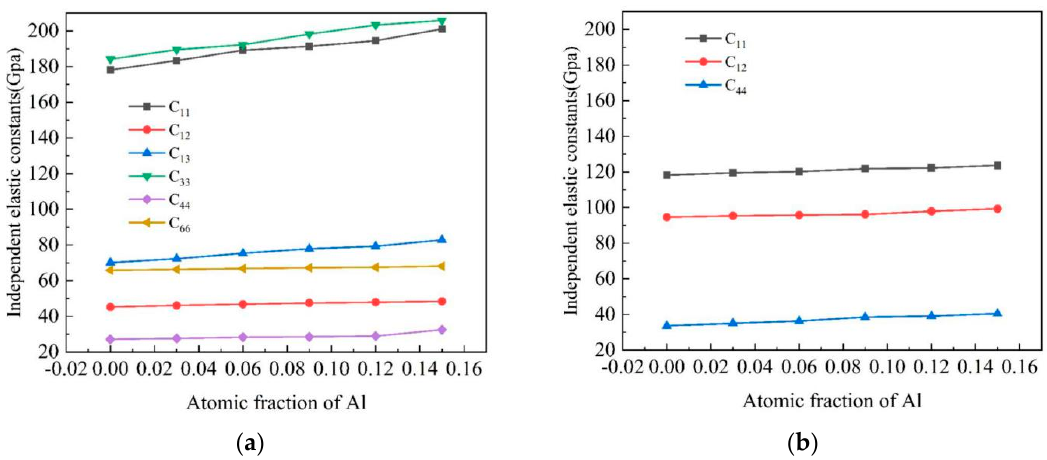
Figure 4. ( a ) Effect of Al atomic fraction on the independent elastic constants of HCP-structured Zr-Ti-Al